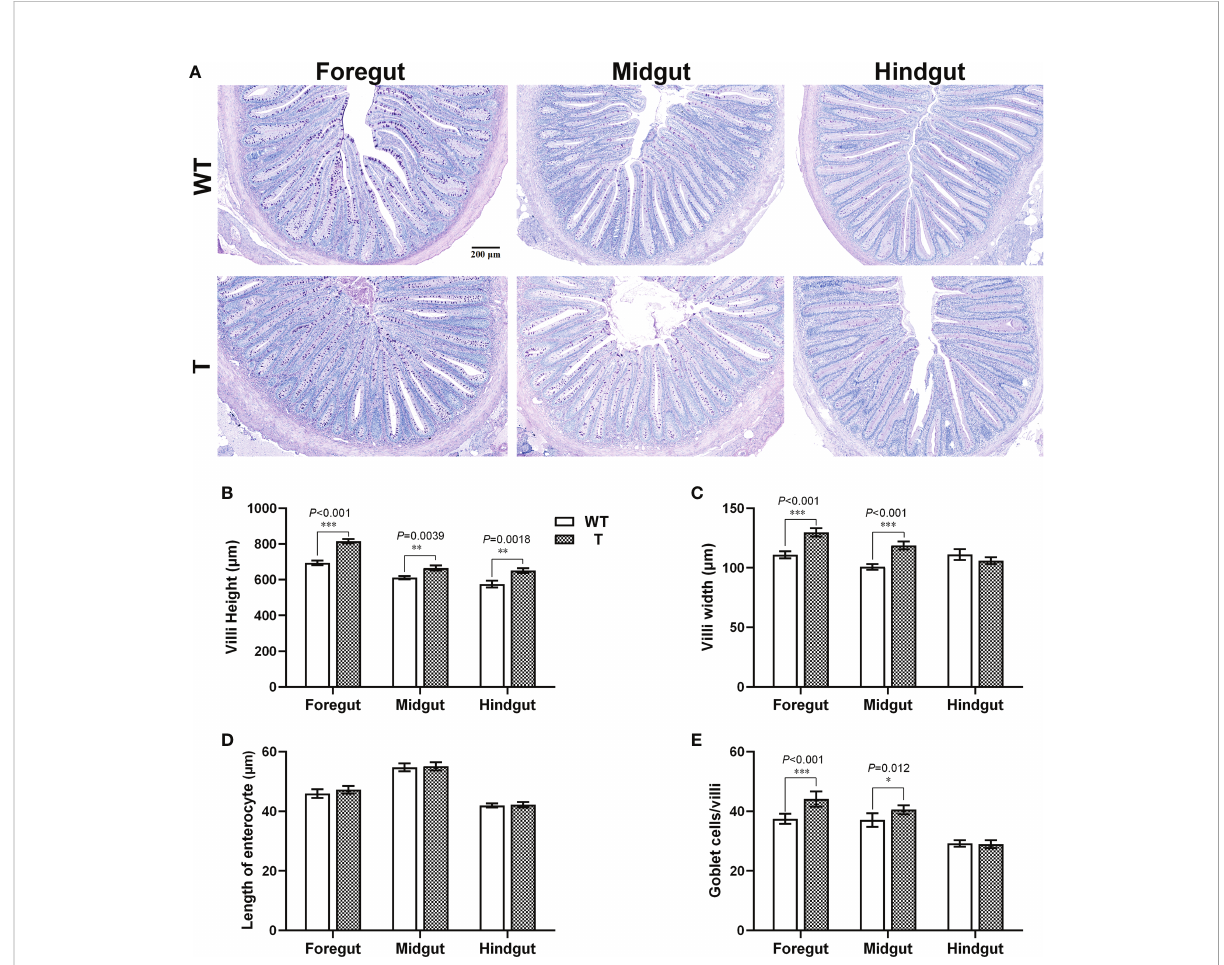
FIGURE 2 Intestinal histology of 4-month-old T and WT common carp. (A) Intestinal sections stained with PAS. Scale bars, 200 m m (7×). The arrows indicate goblet cells. (B – E) Villus height, villus width, length of enterocyte, and the number of goblet cells per villus in the intestine (n = 6). WT, wild-type common carp. T, GH transgenic common carp. * P < 0.05, ** P < 0.01, *** P <